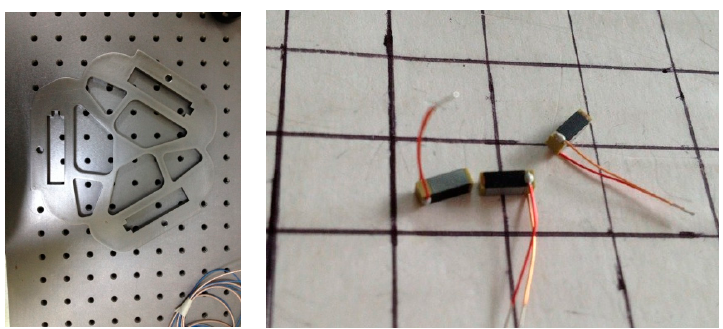
Figure 20. The physical model of the optimized material and PZT actuator. Table 6. The parameters of PZT actuator.